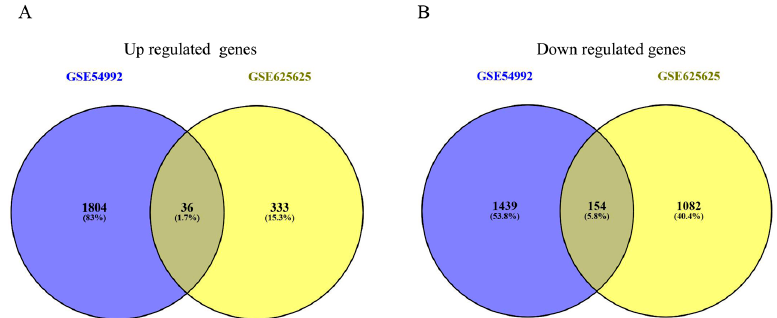
Figure 2. Selection of 190 commonly DEGs from the GSE54992 and GSE62525. Different color areas showed different datasets. The cross areas meant the overlapping changed DEGs. ( A ) Up regulated genes. ( B ) Down regulated genes.